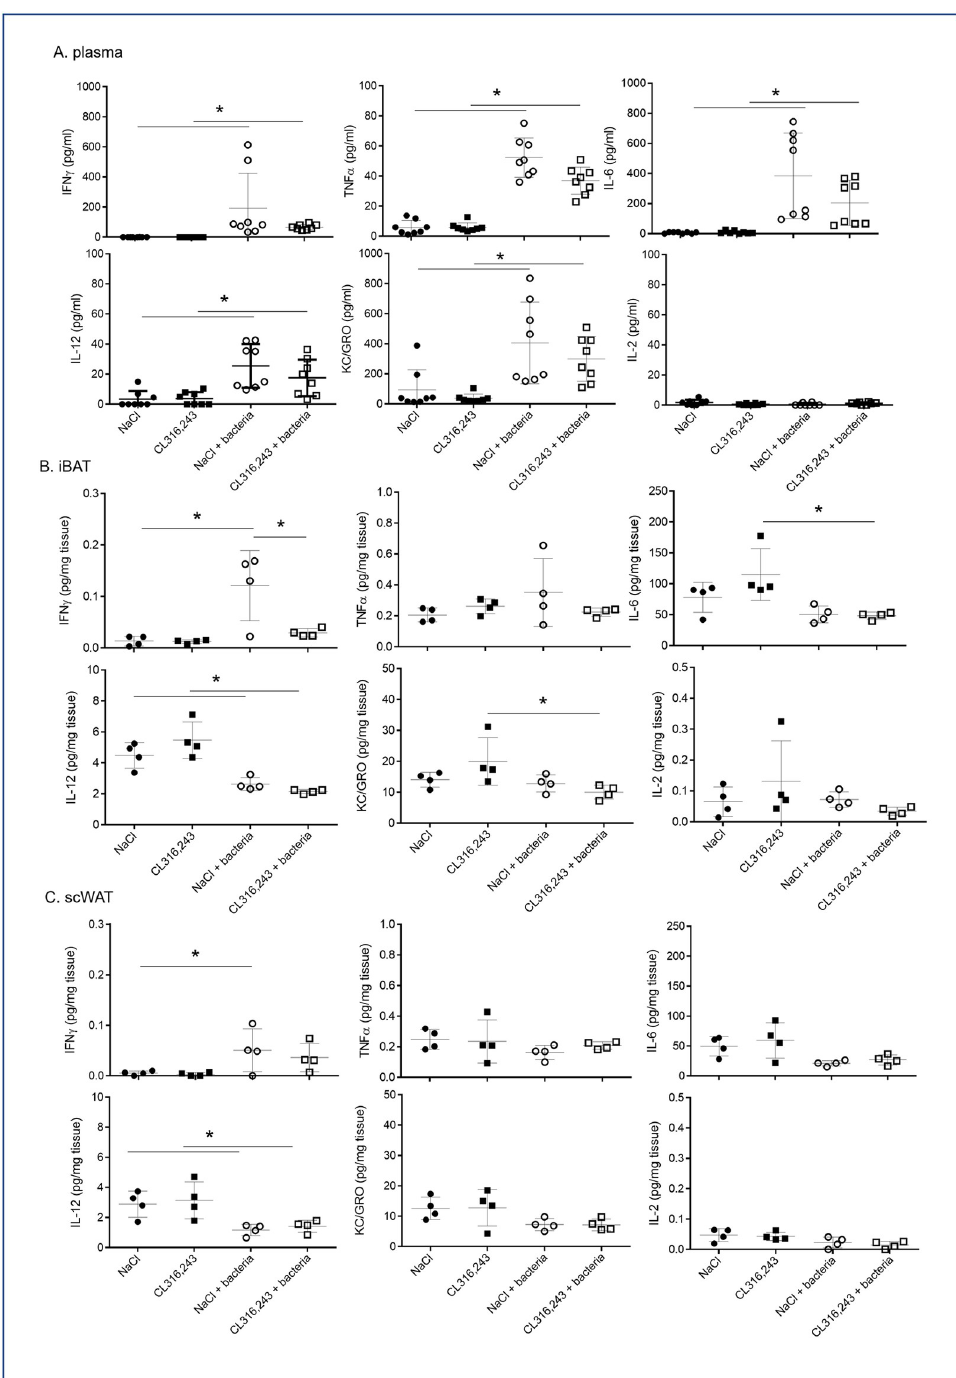
Fig 4. Systemic and local inflammatory responses to infection. IFN γ , TNF α , IL-6, IL-12-p70, KC/GRO (CXCL-1) and IL-2 levels were assessed in the plasma (A) or in the media of iBAT (B) and scWAT (C) explants from mice that were treated for 1 week with CL316,243 daily (1 mg/kg/day) or vehicle only (NaCl), and infected with E . coli for 48 hours. The results are displayed as independent values (dots) and the mean ± SD. n = 8 (plasma) or 4 (explants). � p < 0.05.